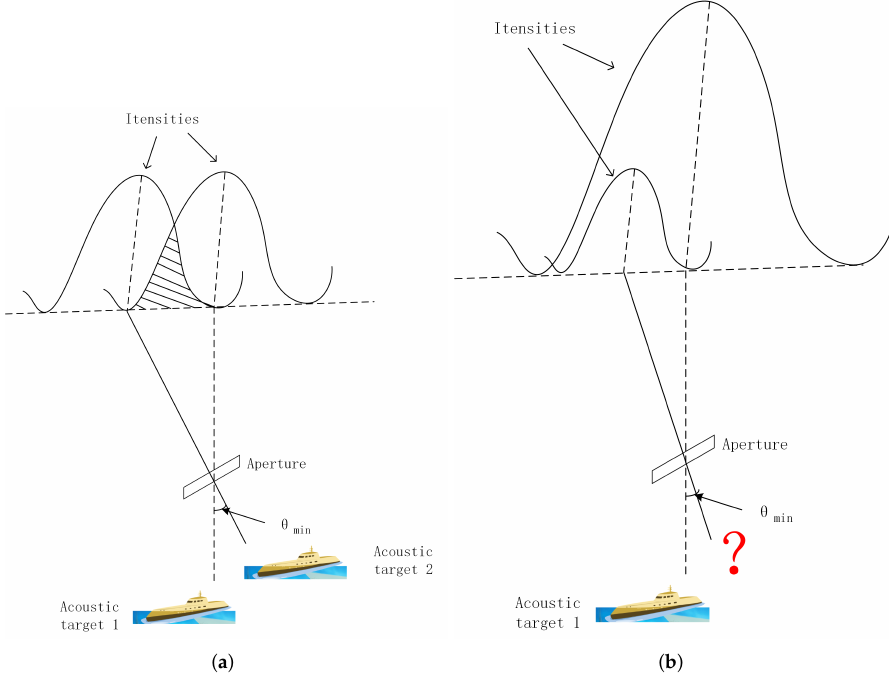
Figure 1. Explanation of Rayleigh Limit. ( a ) Distinguishable Target; ( b ) Indistinguishable Target with strong jamming